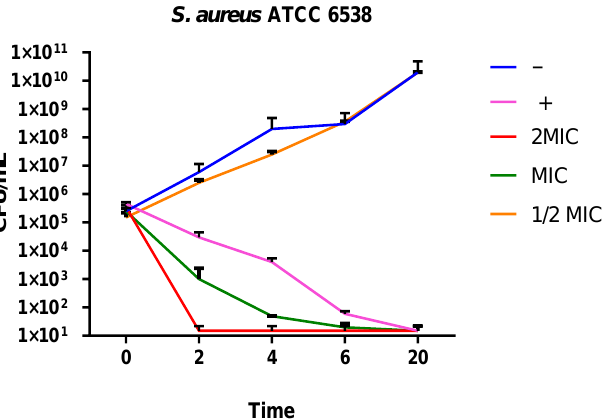
Figure 4. Time-killing assay. Killing kinetics of Hylin-a1 against S. aureus strains. ( − ): bacteria treated with the solvent used to dissolve the drug; (+): bacteria treated with vancomycin (6.9 µ M); (2MIC): bacteria treated with Hylin-a1 (12.5 µ M); (MIC): bacteria treated with Hylin-a1 (6.25 µ M); ( 1 / 2 MIC): bacteria treated with Hylin-a1 (3.125 µ M).